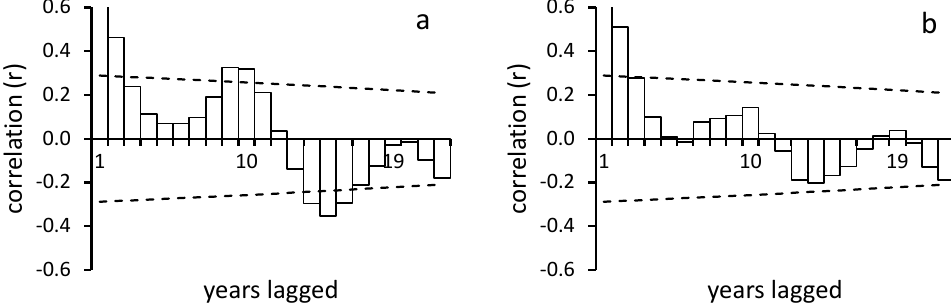
Figure 5. Autocorrelations of the annual abundances of ( a ) Zophosis devexa and ( b ) Caurica velox . Dotted lines are confidence limits.